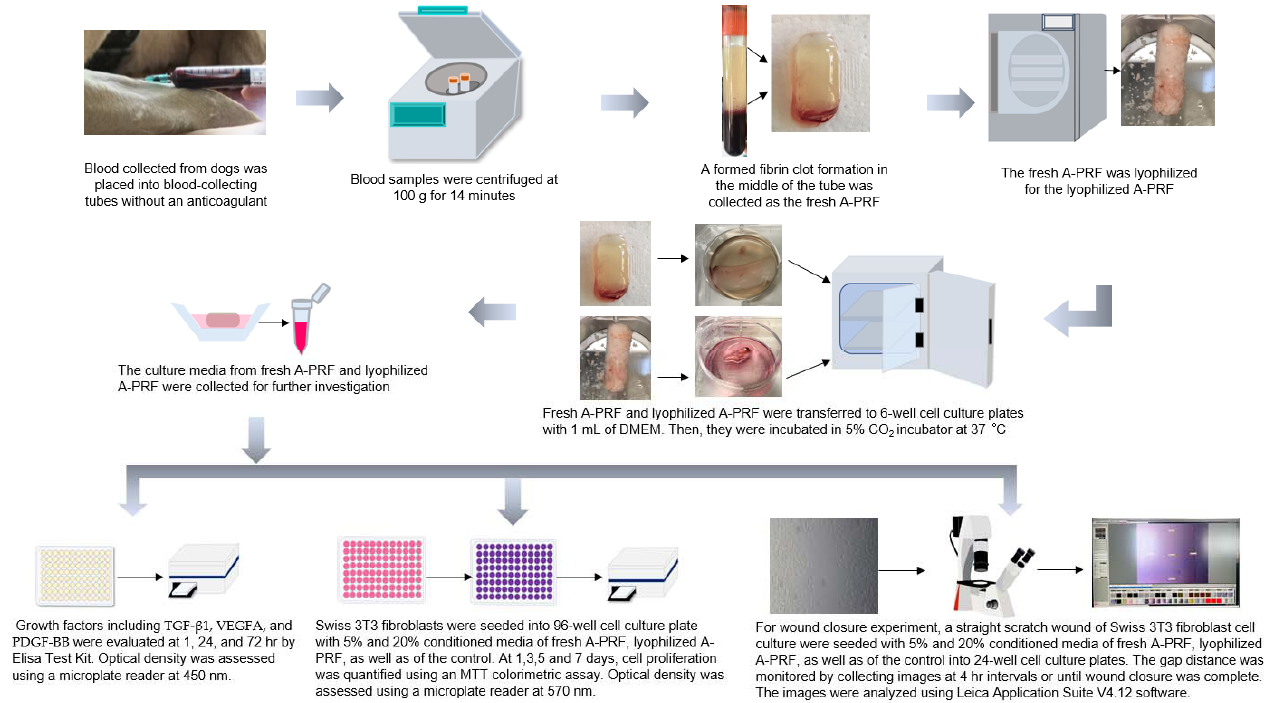
Figure 1. Schematic outline of experiments comparing the fresh canine advanced platelet-rich fibrin (fresh A-PRF) and the lyophilized canine advanced platelet-rich fibrin (lyophilized A-PRF) on growth factor release, including transforming growth factor beta-1 (TGF- β 1), vascular endothelial growth factor-A (VEGFA), and platelet-derived growth factor-BB (PDGF-BB), in addition to the enhancement of fibroblast proliferation and wound closure. DMEM: Dulbecco’s Modified Eagle Medium.